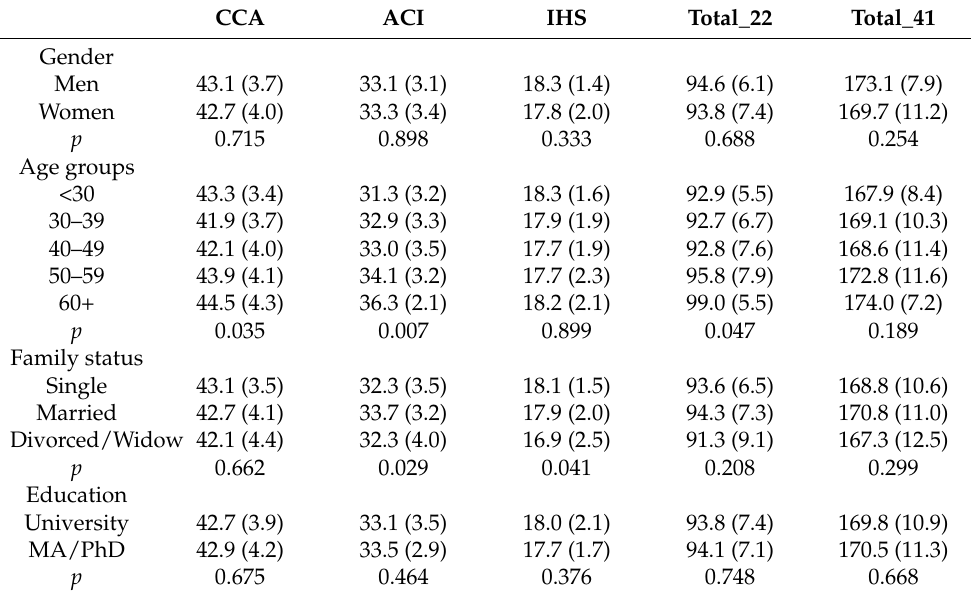
Table 3. Association of empathy with sociodemographic variables—means